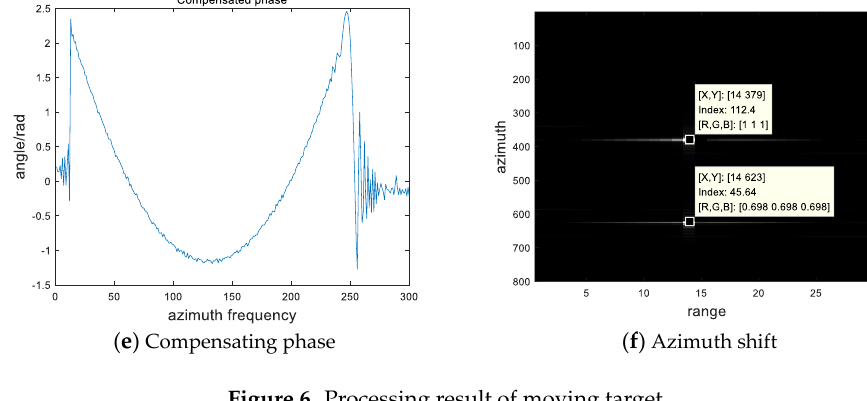
Figure 6. Processing result of moving target. Table 3. Quality evaluation of autofocusing target. Table 4. Velocity estimation results.